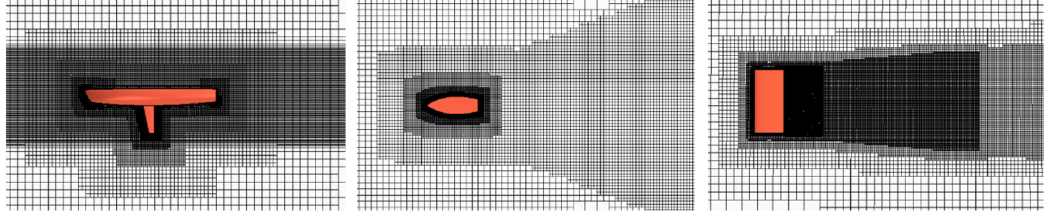
Figure 12. Setup of the computational domain of sail downwind ( left ) and upwind ( right ).